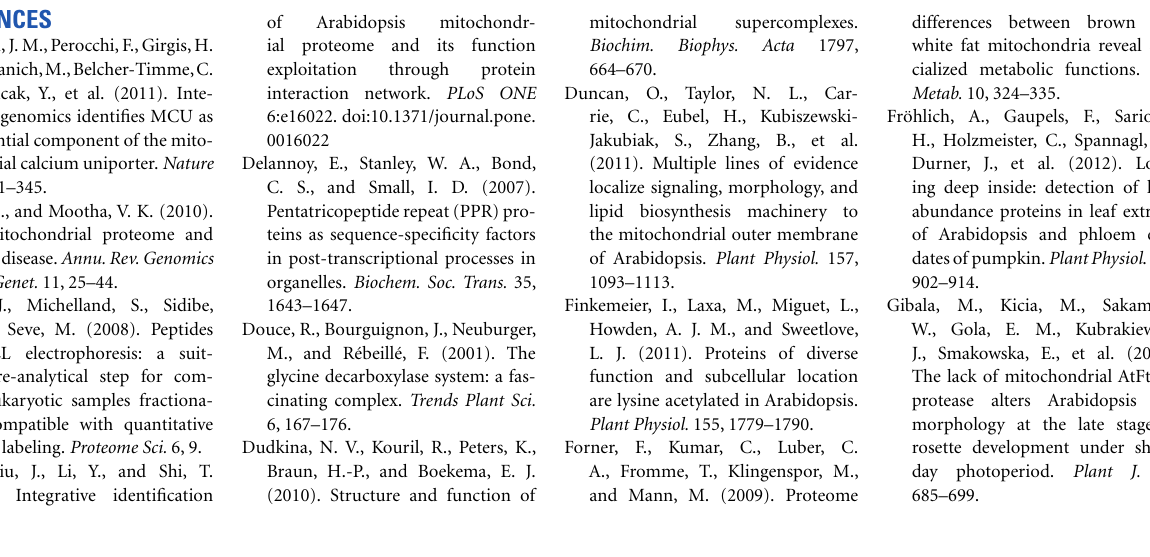
Table S1 | Mitochondrial proteins identified by mass spectrometry or fluorescent protein localization studies. (A) All proteins identified from isolated mitochondria from Arabidopsis using proteomics in the last 5years. (B) A set of proteins which has a high probably being located in the mitochondrion. For the inclusion of a protein in the list, it should meet the following criteria: (i) A protein is automatically considered mitochondrial if at least two studies have identified it in isolated mitochondrial fraction. However, a protein is considered to be non-mitochondrial if it is identified in equal number of or more non-mitochondrial proteomics studies than the mitochondrial ones. (ii) If the location of a protein is verified independently by fluorescent protein localization analysis, then (ii) is ignored and it is included in the list. (iii) If a protein is identified by one study, the localization based on SUBAcon score and/or ARAMEMNON localization consensus score is also considered. (C) Mitochondrial protein confirmed through fluorescent protein localization studies (according to SUBA) only and not by